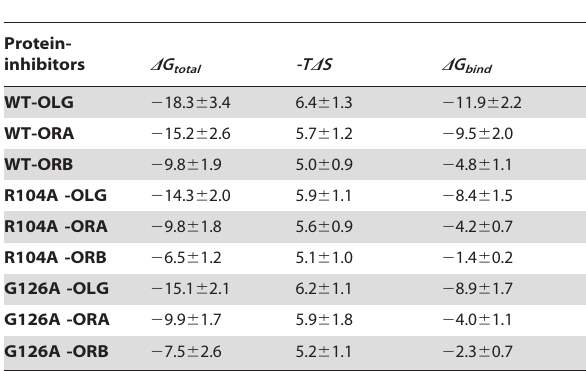
Table 3. The values of the binding free energy ( D Gbind ) and the number of binding sites (n) of the a -HL-inhibitor systems based on the results from the fluorescence-quenching method.